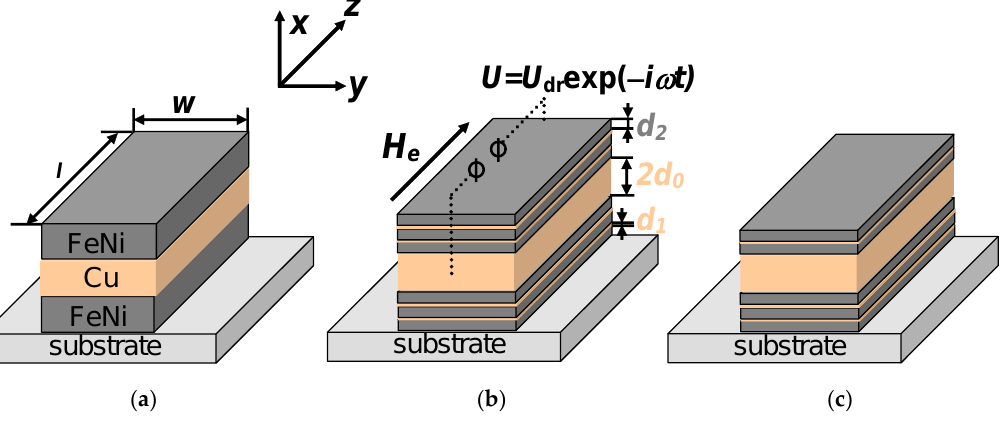
Figure 1. Schematic representation of the MI multilayered sensitive elements. ( a ) Classic “MI sandwich” without nanostructuring of magnetic layers. ( b ) MI symmetric multilayer with the same total thickness of FeNi top and bottom layers, both deposited as multilayers with Cu spacers. ( c ) MI non-symmetric multilayer with different total thicknesses of top and bottom layers: top multilayer contains two FeNi sub-layers and bottom multilayer contains three FeNi sub-layers in this particular case.